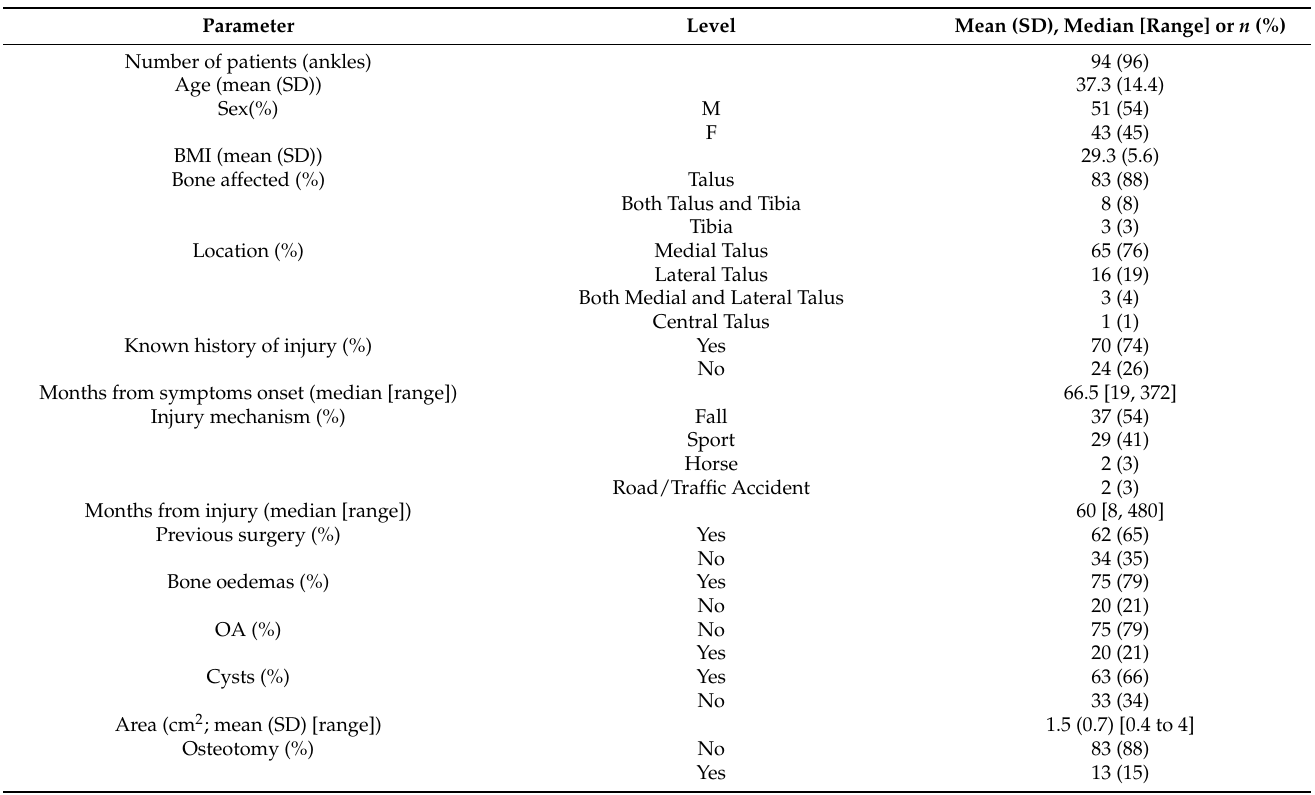
Table 1. Baseline demographic and clinical